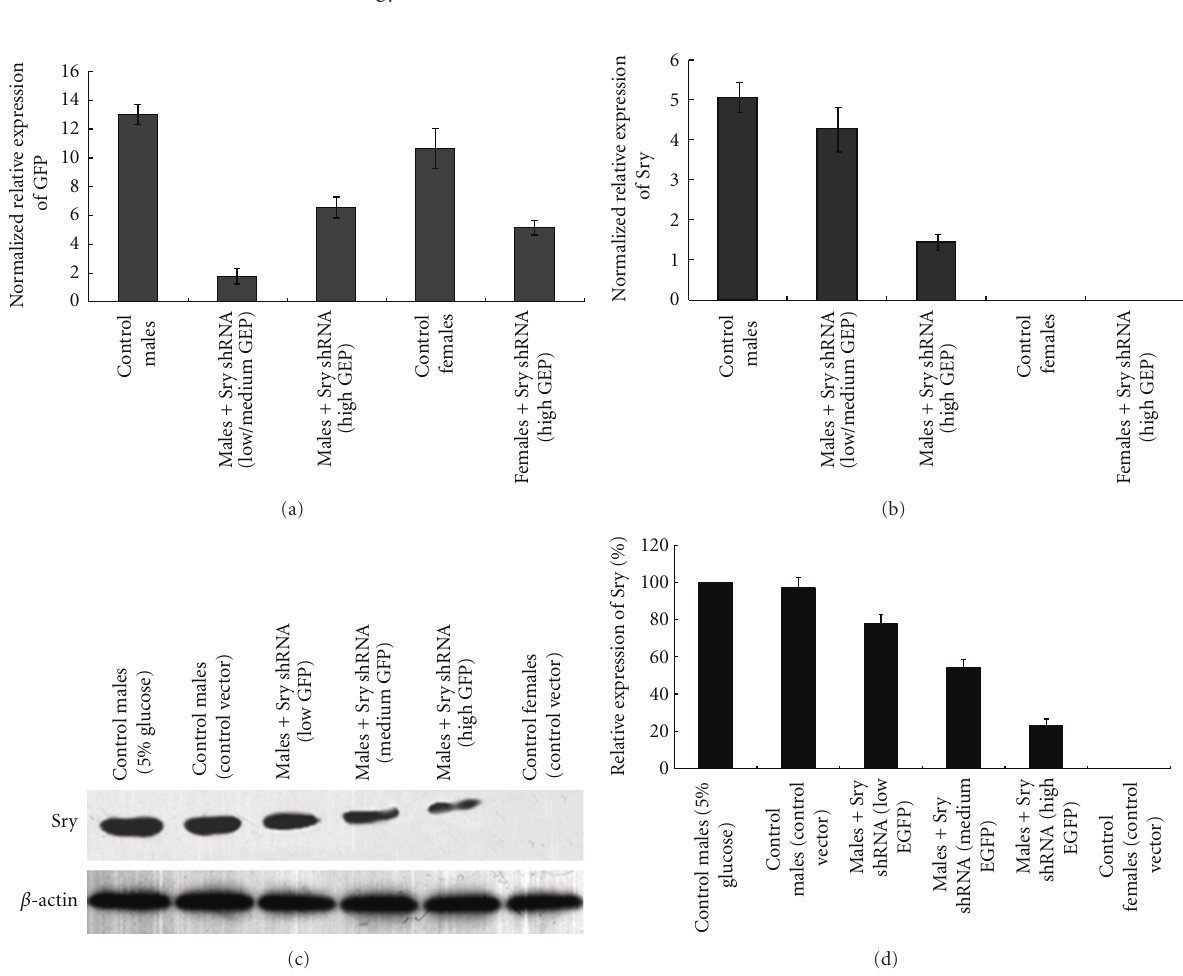
Figure 2: Quantitative RT-PCR and Western-blotting analysis to detect the expression of gonadal GFP and Sry expression in embryonic mouse gonads. Gonads at 11.5 dpc were grouped on the basis of overall GFP expression observed at the macroscopic level. Quantitative RT-PCR was then carried out on grouped gonads. Gene expression was normalized to IL3 (autosomal in mouse) (mean ± SEM; n = 3). (a), Relative expression of GFP in embryos. Relative high level of GFP expression was found in controls, and variable expression levels of GFP in male and female gonads with Sry knockdown. (b) Sry expression in control and Sry knockeddown gonads. (c) Western-blotting analysis of Sry expression. Control males which treated with 5% glucose solution or negative control vector (pSilencer4.1/EGFP), males embryos treated with Sry shRNA (pSilencer4.1/Sry565) and with low, medium, or high GFP expression, and the control females treated with control vector and show high GFP expression were all collected at 11.5dpc and each gonad were separated for protein isolation. Western-blotting were performed to determine the SRY expression level in each group of embryos and β -actin was also be detected as a loading control. (d) Quantitative analysis of the Sry protein level. The expression of Sry was determined by Western blot. The value of Sry protein expression level was normalized to the β -actin expression level and the relative expression level of Sry in embryos which treated by 5% glucose solution was set at 100%. Results are expressed as the mean ± SEM, ( n >